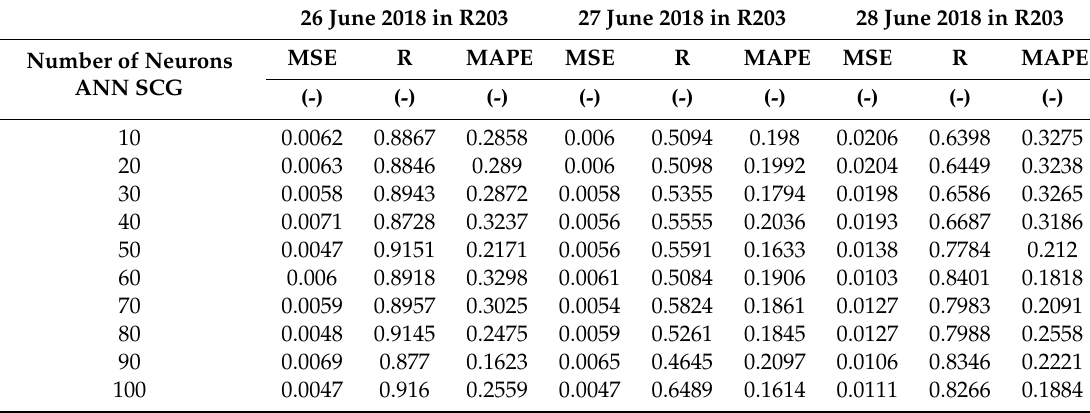
Table 2. Learned ANN SCG from 25 June 2018 in R203 (with T in and rH in ) and prediction with cross-validation for 26 June 2018 in R203 (with T in and rH in ), 27 June 2018 in R203 (with T in and rH in